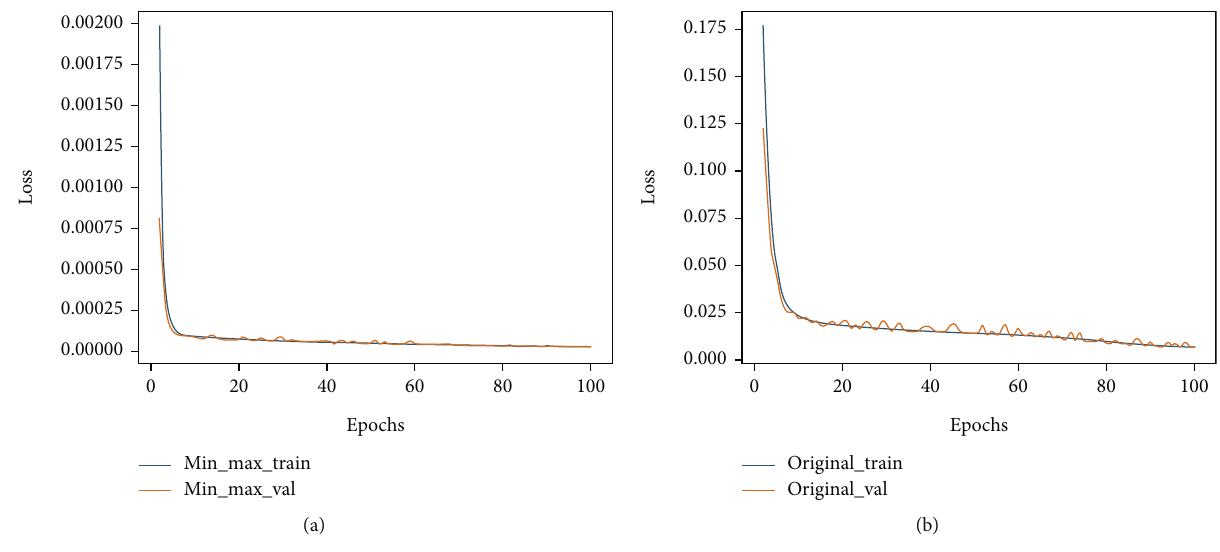
Figure 7: Raw and min-max data for network